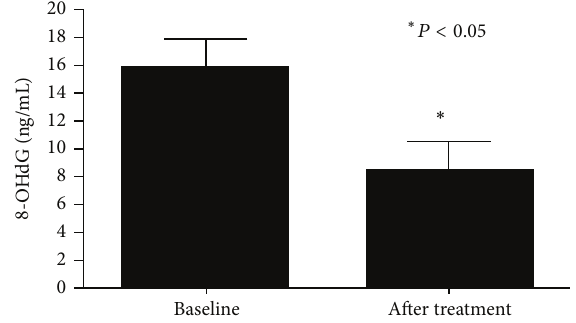
Figure 2: 8-Hydroxy-2 󸀠 -deoxyguanosine (8-OHdG) level in patients with Alzheimer’s disease (group 1) before and after fermented papaya powder (FPP) supplementation.